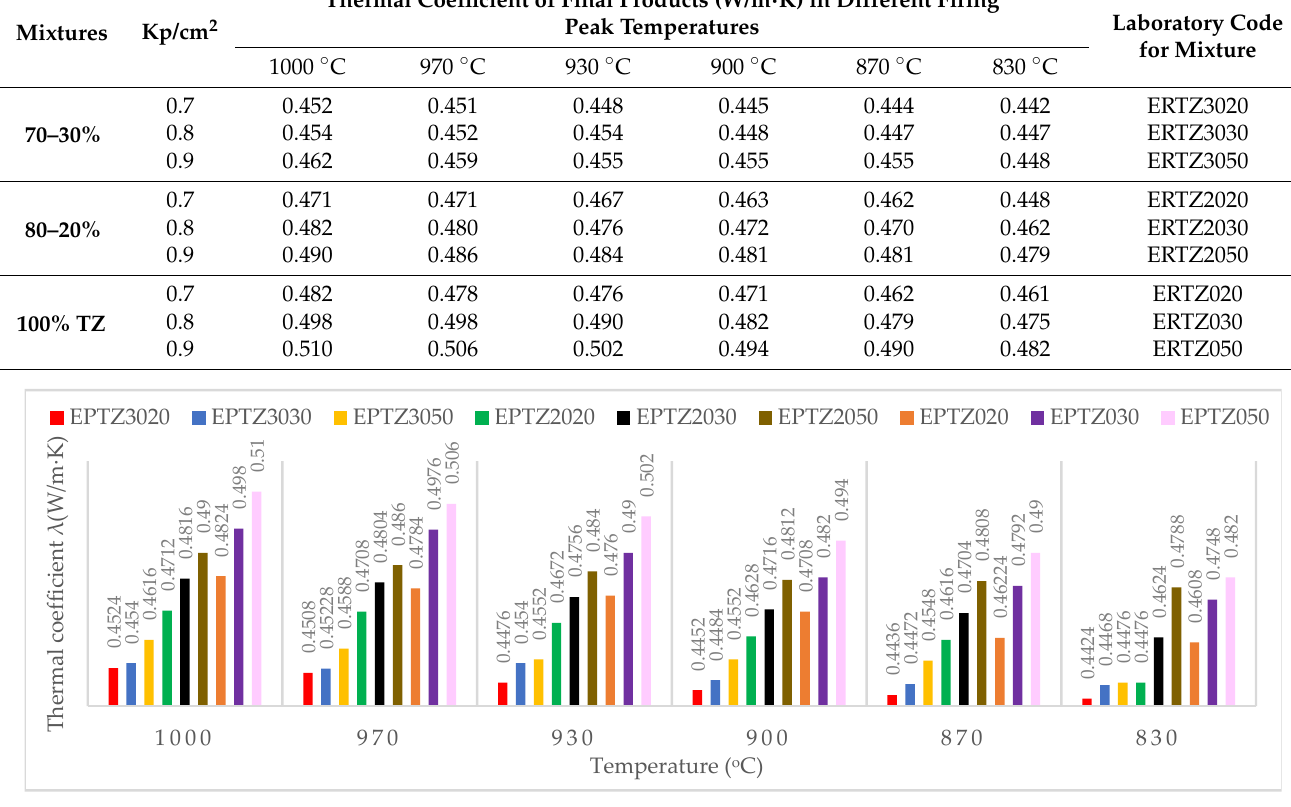
Table 9. Thermal conductivity coefficient of the tested